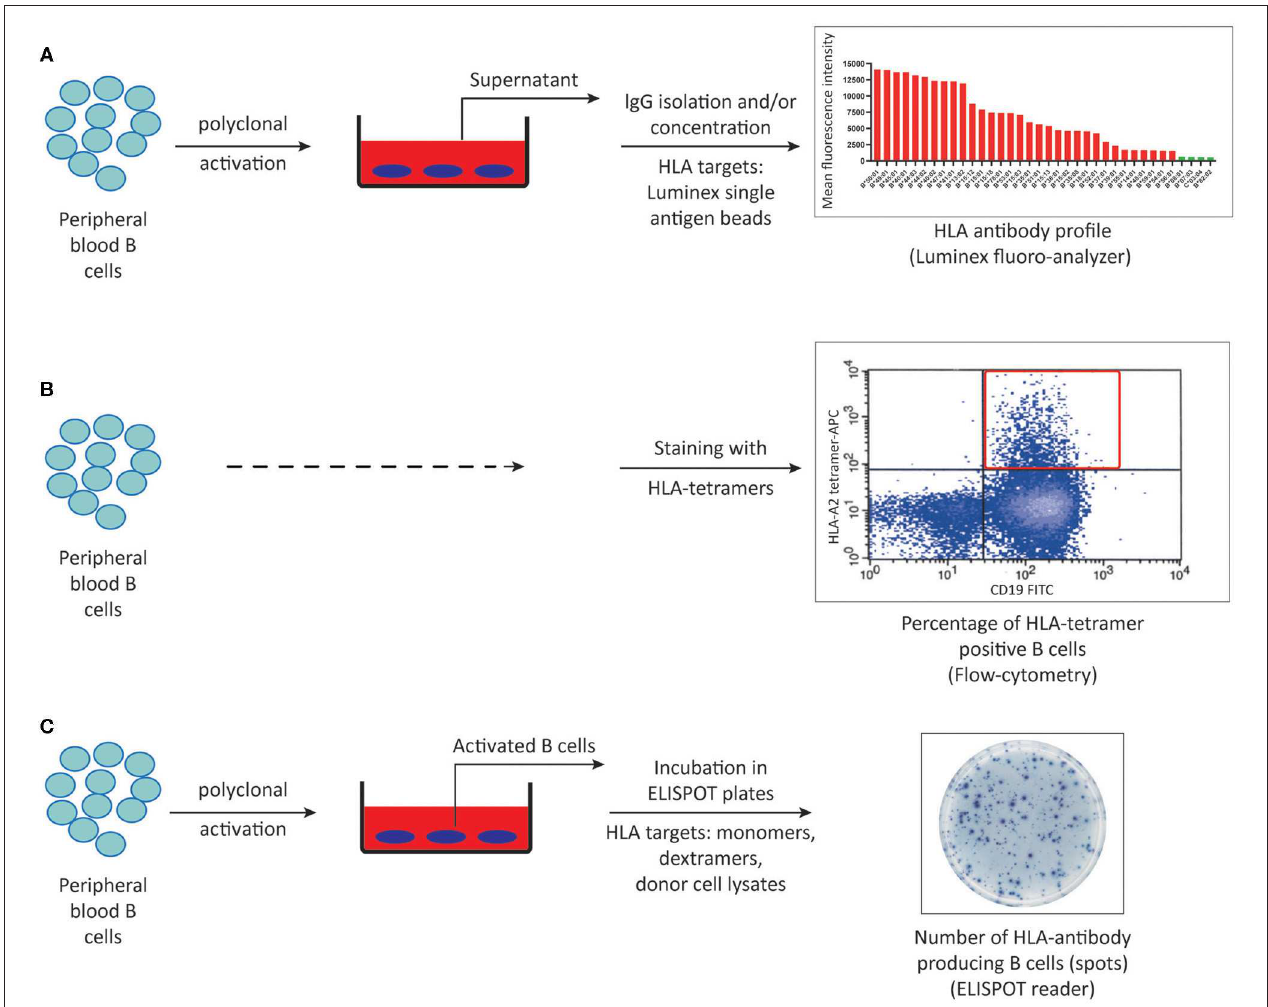
FIGURE 3 | Methods to detect HLA-specific memory B cells. (A) Peripheral blood B cells can be polyclonally activated and IgG isolated culture supernatants can be screened for memory B cell derived-HLA antibodies using luminex single antigen bead assays. (B) Peripheral blood B cells can be stained with HLA-tetramers using flow cytometry. (C) HLA-specific memory B cells can be quantified by ELISPOT assay using either synthetic or donor-derived HLA molecules following in vitro polyclonal activation. ELISPOT, Enzyme-linked immunosorbent